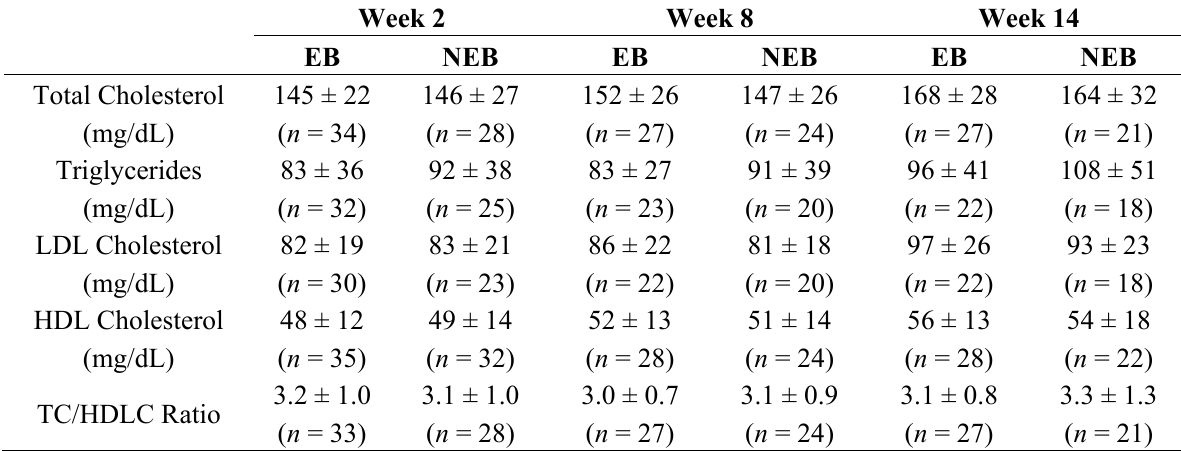
Table 5. Changes in fasting plasma lipids over time by breakfast